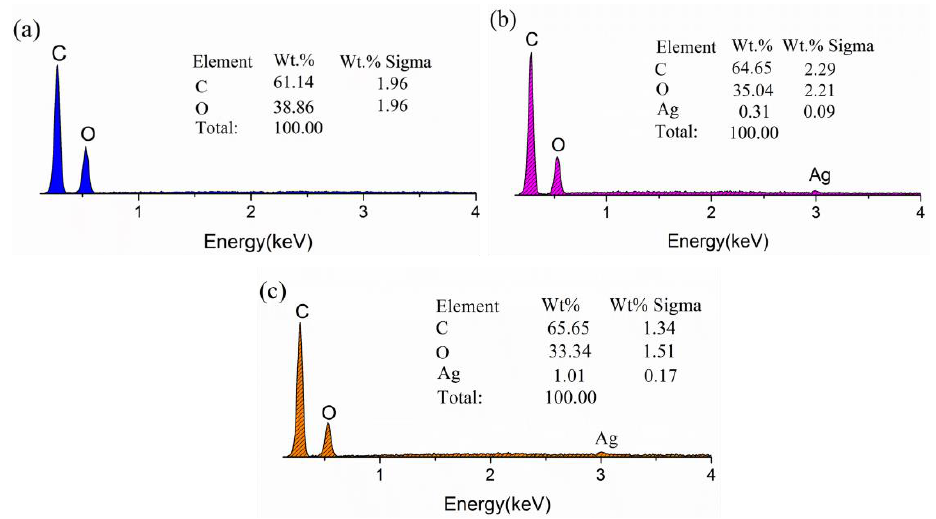
Figure 5. EDX spectra of PLA nonwoven fabrics: ( a ) control; ( b ) CS-Ag NPs treated; ( c ) DBD-CS-Ag NPs treated.